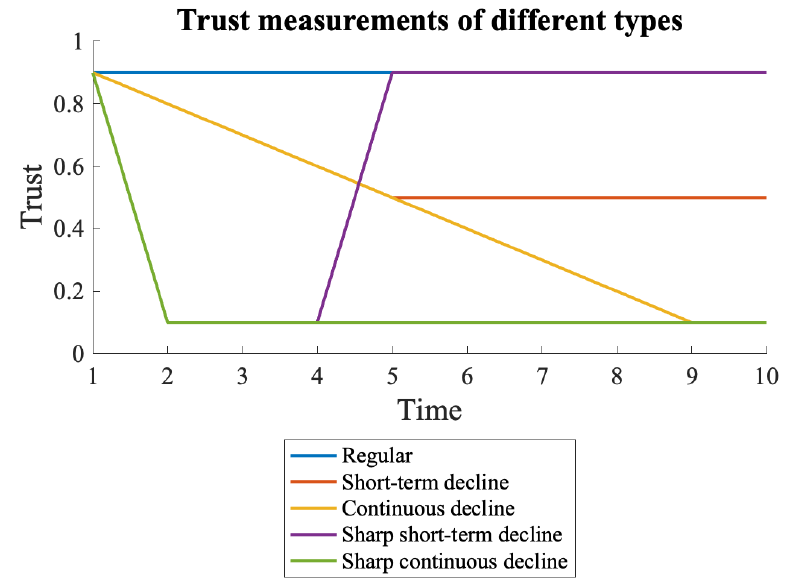
Figure 2. Trust measurements while different types of attacks